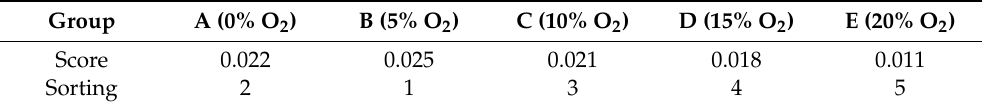
Table 4. Evaluation results using